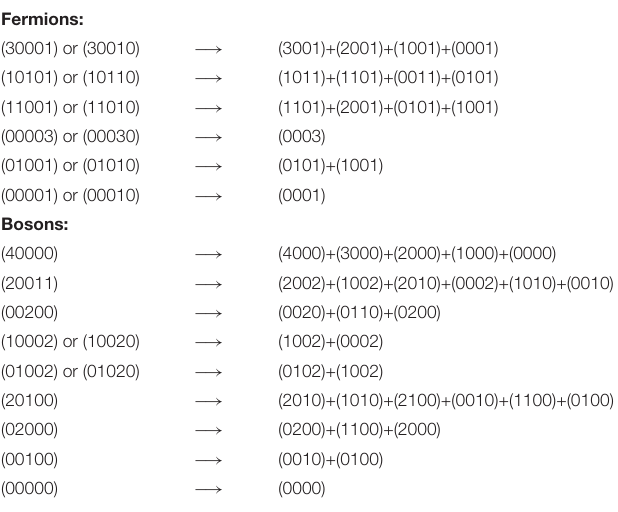
TABLE 2 | 0(10) → 0(9) Branching of massless on-shell states upon reducing D = 12 → D = 11.